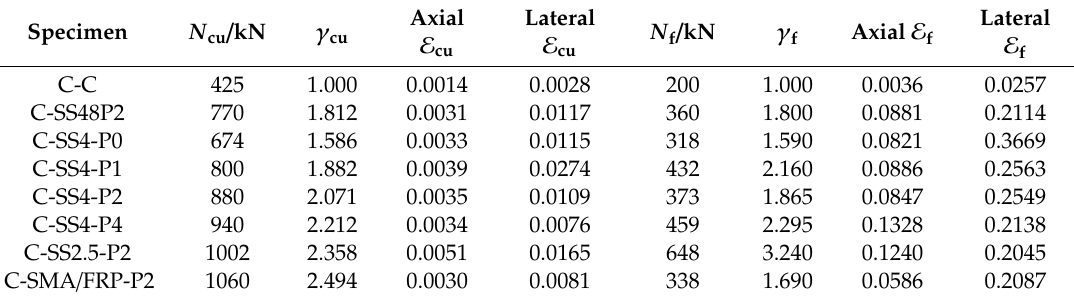
Figure 7. Axial load-displacement curves of concrete columns: ( a ) Axial load-displacement curve of concrete cylinders with different SMA wires reinforcement amount and ( b ) Axial load-displacement curve of concrete cylinders with different prestrain level of SMA wires. Table 4. Axial compressive bearing capacity and deformation of concrete cylinders.